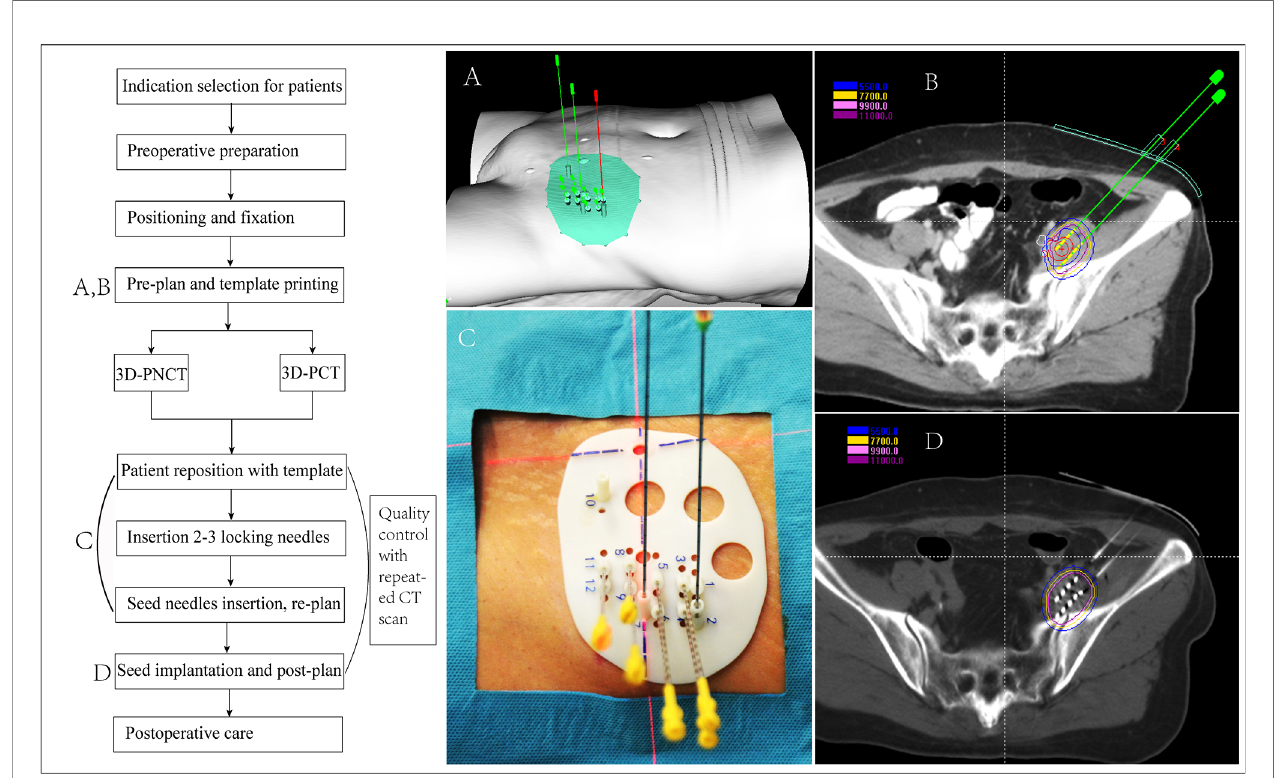
FIGURE 2 | Flow chart of 3D printing template-assisted CT-guided iodine 125 seed implantation for recurrent cervical cancer. 3D-PCT, 3D printing co-planar template; 3D-PNCT, 3D printing non-co-planar